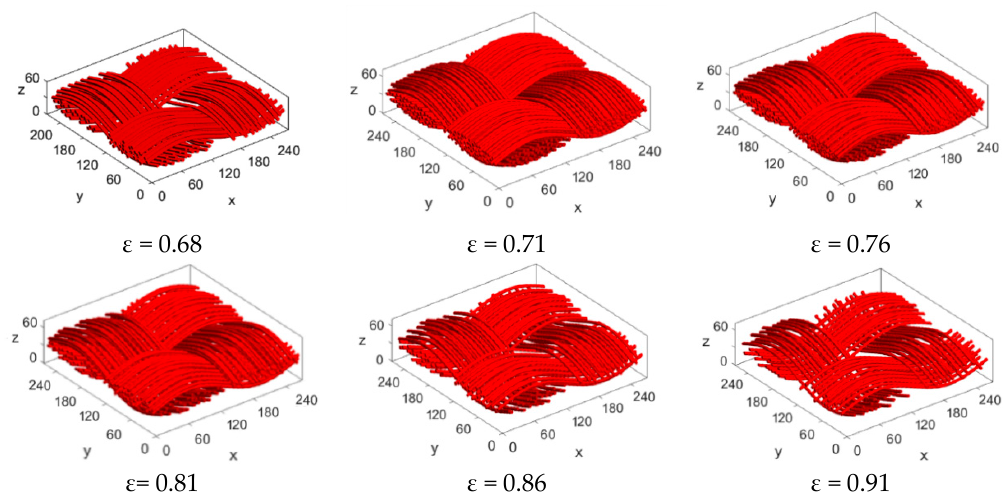
Figure 7. Carbon cloth models with different porosities (fiber radius = 3 μ m).